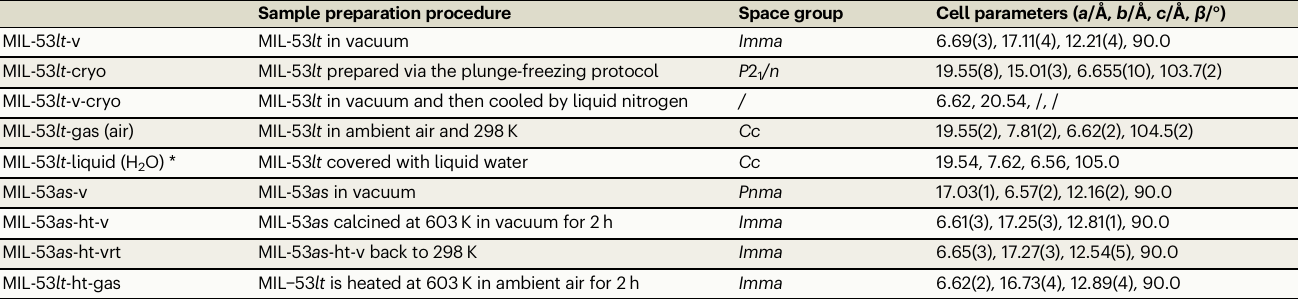
Table 1 | Sample preparation procedures, space group and unit cell parameters of different phases of MIL-53 obtained from environmental 3DED data Sample preparation